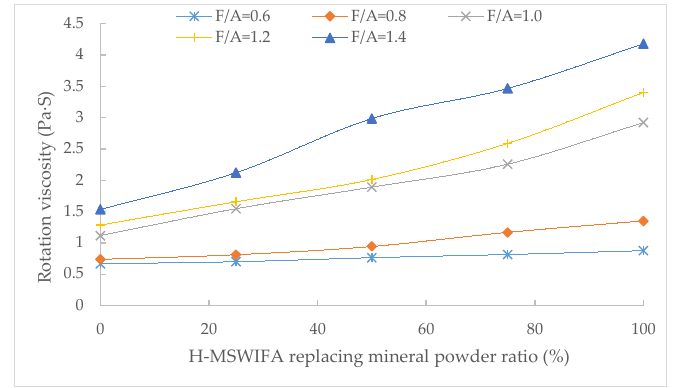
Figure 3. Rotational viscosity test results of asphalt mastics.